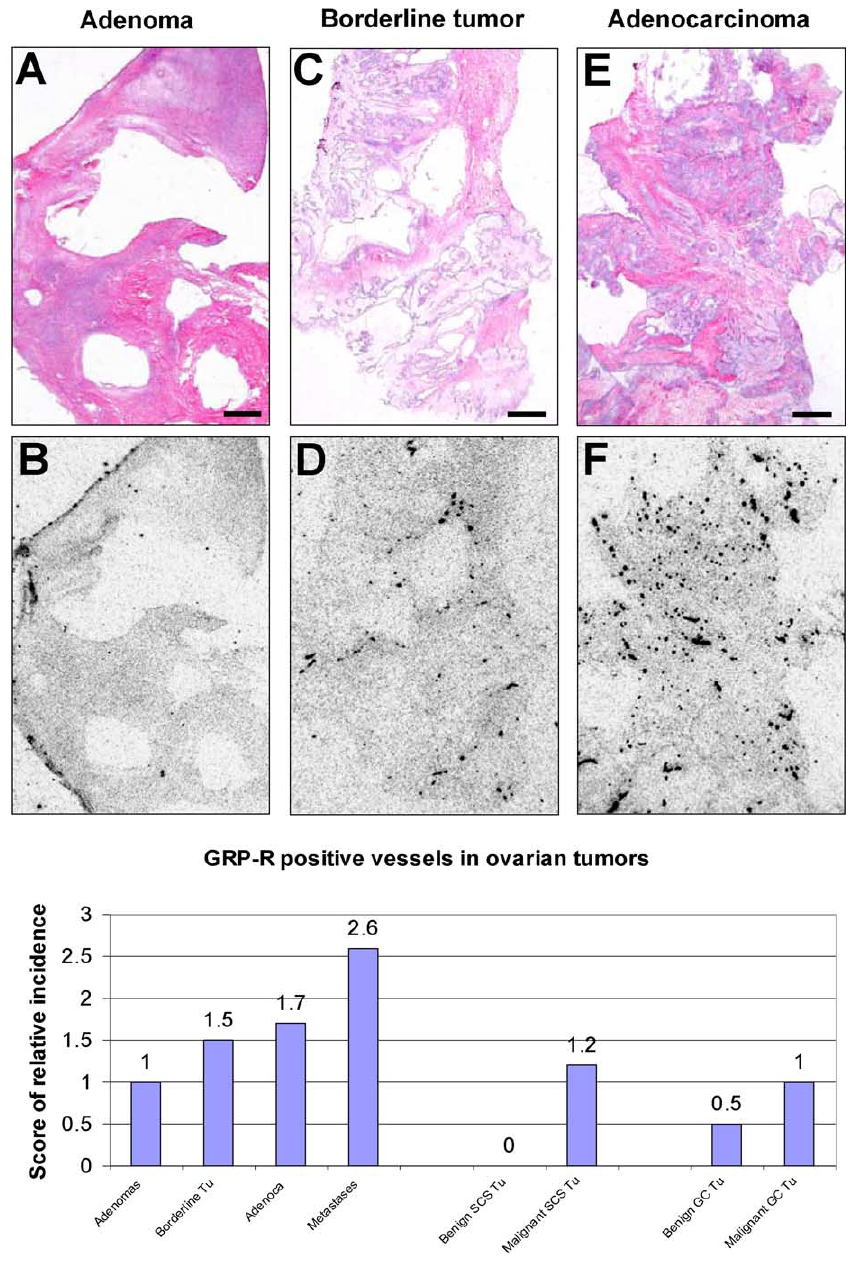
Fig. 3. Increasing incidence of GRP-receptor positive blood vessels with increasing malignant potential in tumor groups of different categories. The top part (A–F) represents GRP-receptor autoradiographies of epithelial–stromal tumors. The bottom part is a histogram representing the score of the incidence of GRP-receptors positive vessels in various tumor groups. A, C, E: H&E-stained sections of a serous adenoma (A), a serous borderline tumor (C) and a serous carcinoma (E); bars = 1 mm. B, D, F: autoradiograms showing total binding of 125 I-[Tyr 4 ]-bombesin. Absence of GRP-receptor positive vessels in the adenoma (B), but moderate incidence in the borderline tumor (D) and high incidence of GRP-receptor positive vessels in the carcinoma (F), respectively. In all cases, non-specific binding was negligible. The score histogram combines the incidence per tumor area and the incidence per tumor group of GRP-receptor positive vessels in various tumor groups (SCS Tu: sex–cord–stromal tumors, GC Tu: germ cell tumors). The score was determined as follows: the incidence of GRP-receptor expressing vessels per tumor area was graded from 0–3. The sum of all grades in one tumor group was divided by the number of evaluated cases in this group (see